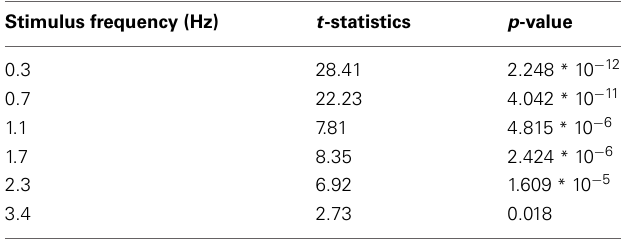
Table A1 | Statistical two-sided paired t -test comparisons of FFT pupil power between presented and absent frequencies ( n = 13).